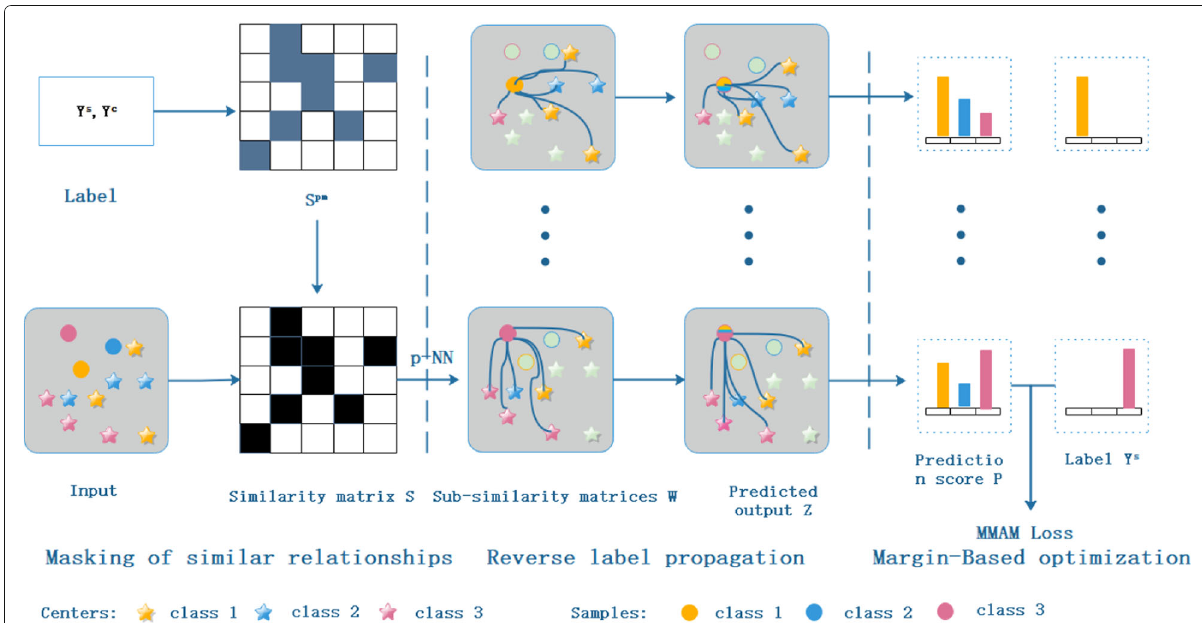
Fig. 1 The overall architecture diagram of our proposed MMAM. The input contains the samples in a mini-batch and all the centers, and the labels include the samples and the pre-defined multi-center labels. Different colors represent different category labels. Multicolor samples indicate